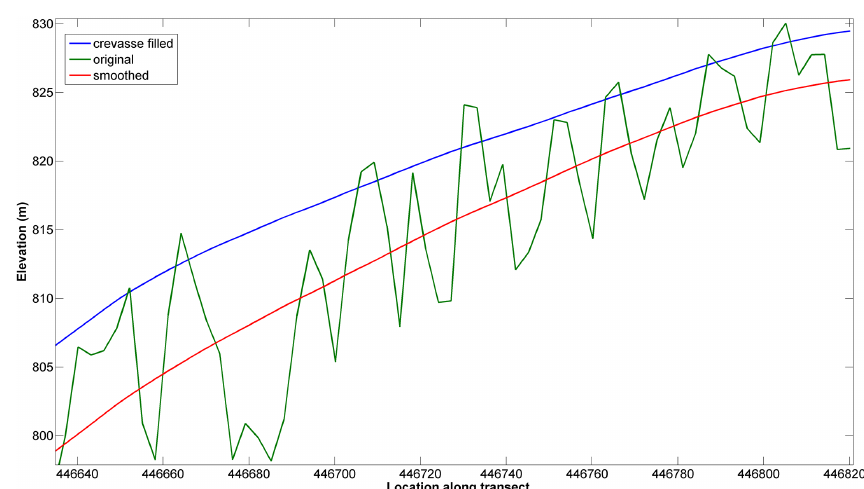
Figure 2. A zoomed-in snapshot of a slice through the DEM. This highlights how the DEM has been “filled”. The green line shows the high frequency surface structure from crevasses, which are removed in the final “filled” surface (blue). The red line shows the first stage of the smoothing, which results in a lower